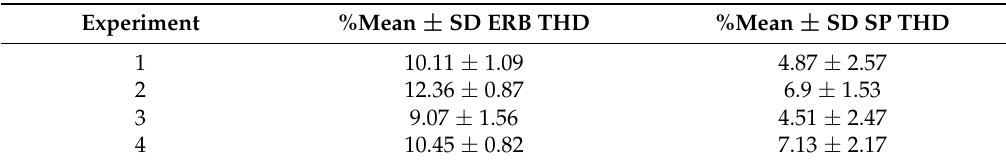
Table 1. THD Comparison Summary.